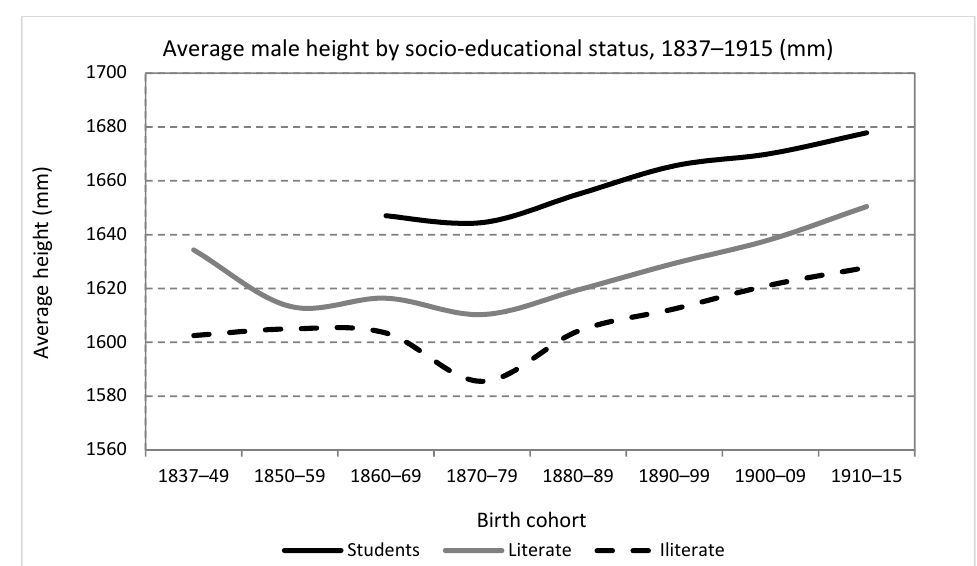
Figure 6. Average male height by socio-educational status, birth cohorts 1837–1915 (Source: calculated with data from the Expedientes .).